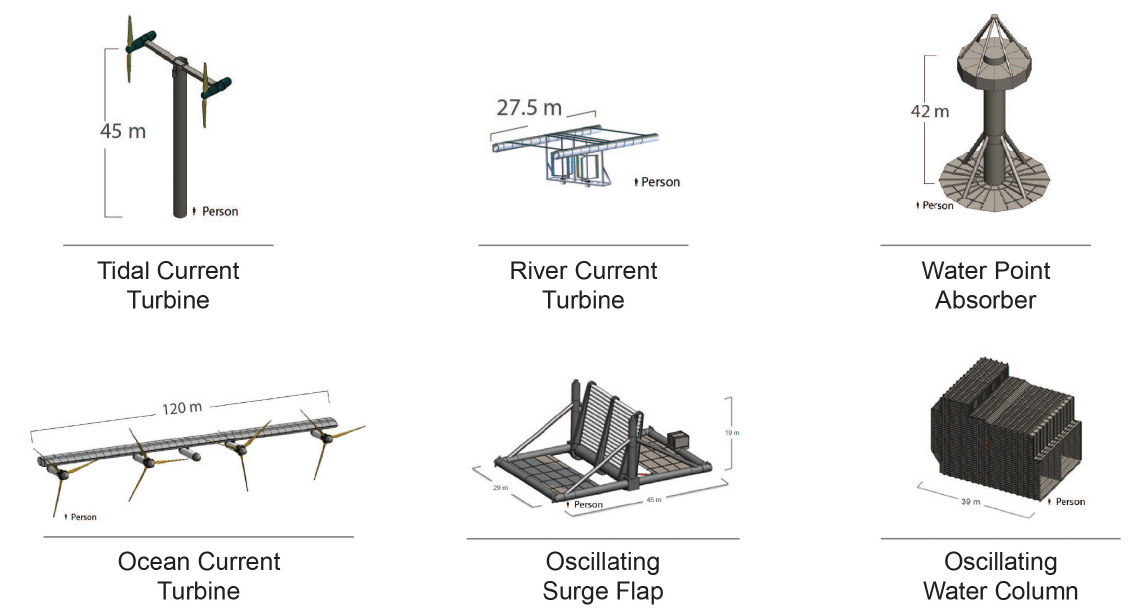
Figure 1. All six reference models developed by the Department of Energy Reference Model project [1]. Graphics courtesy of Sandia National Laboratories.